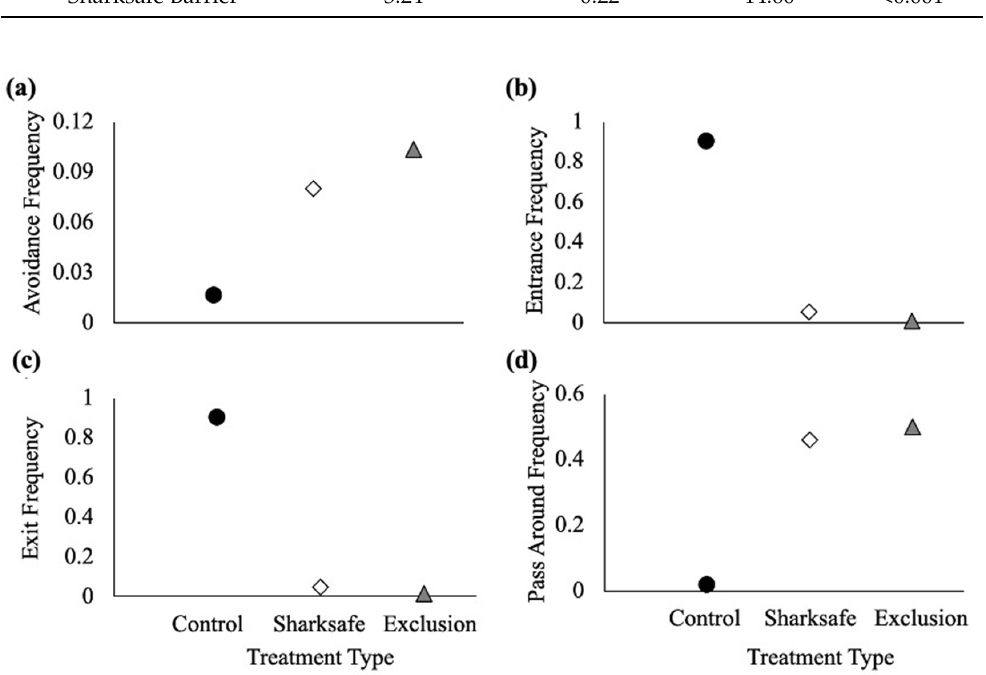
Figure 6. Results from the best fit models for bull shark ( Carcharhinus leucas ) behavior (total quantity of behavior per total visits). ( a ) Avoidance frequency in relation to treatment type. ( b ) Entrance frequency in relation to treatment type. ( c ) Exit frequency in relation to treatment type. ( d ) Pass around frequency in relation to treatment